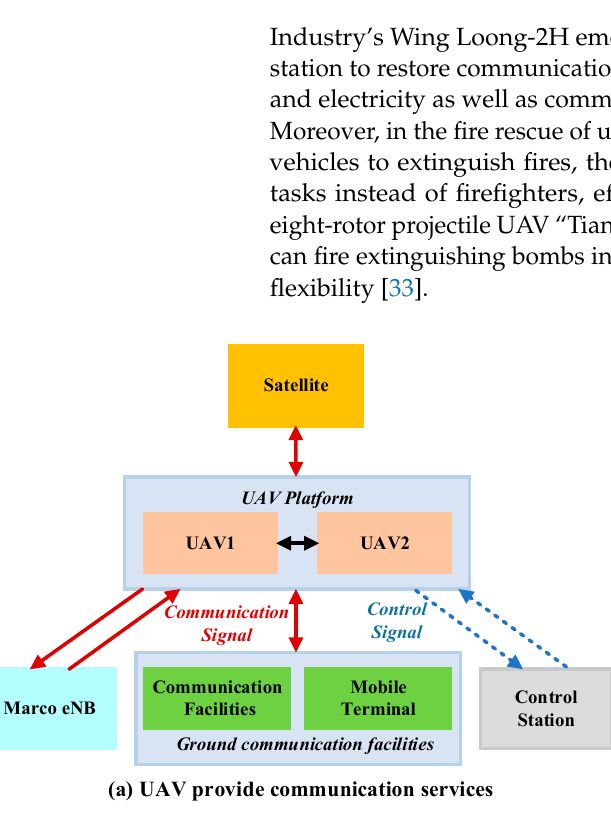
Figure 2. UAV providing services. ( a ) Communication services; ( b ) Delivery services.